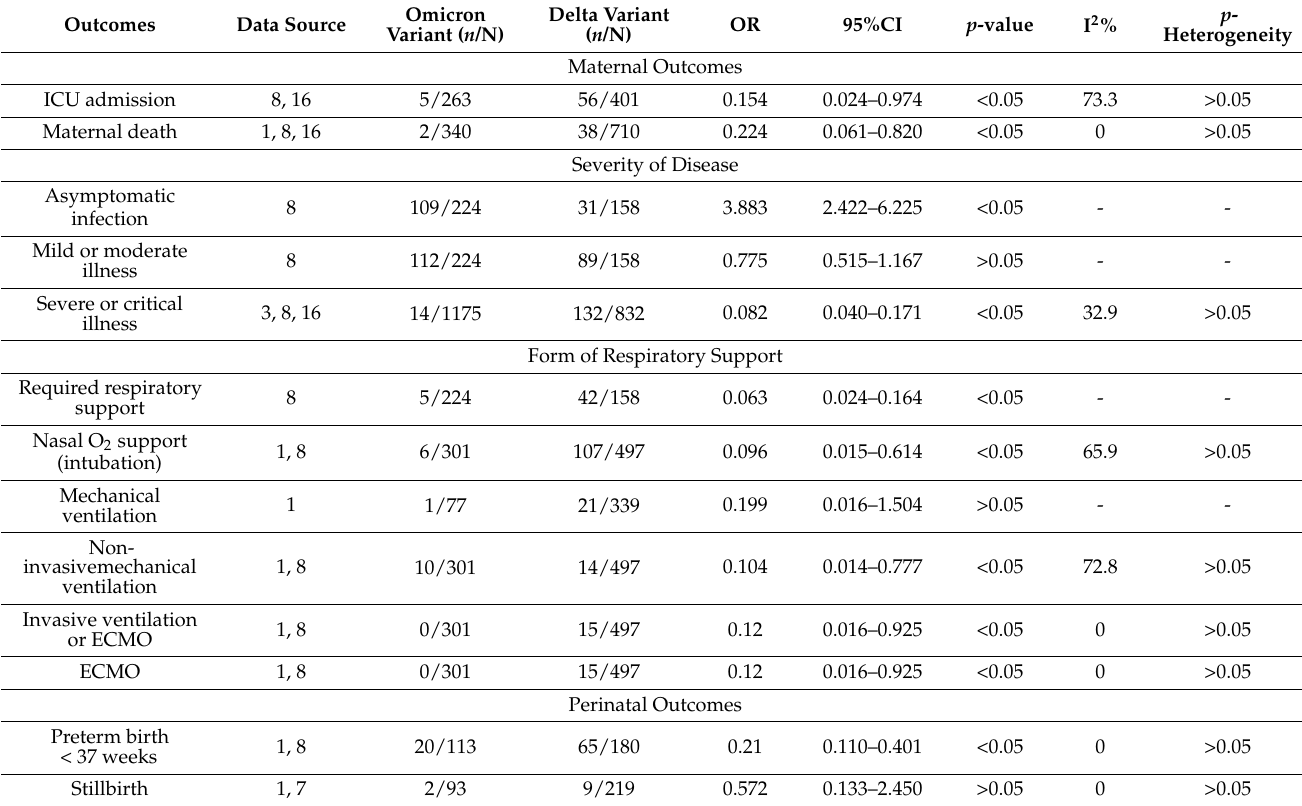
Table 3. Maternal and perinatal outcomes of Omicron or Delta SARS-CoV-2 variant infections during